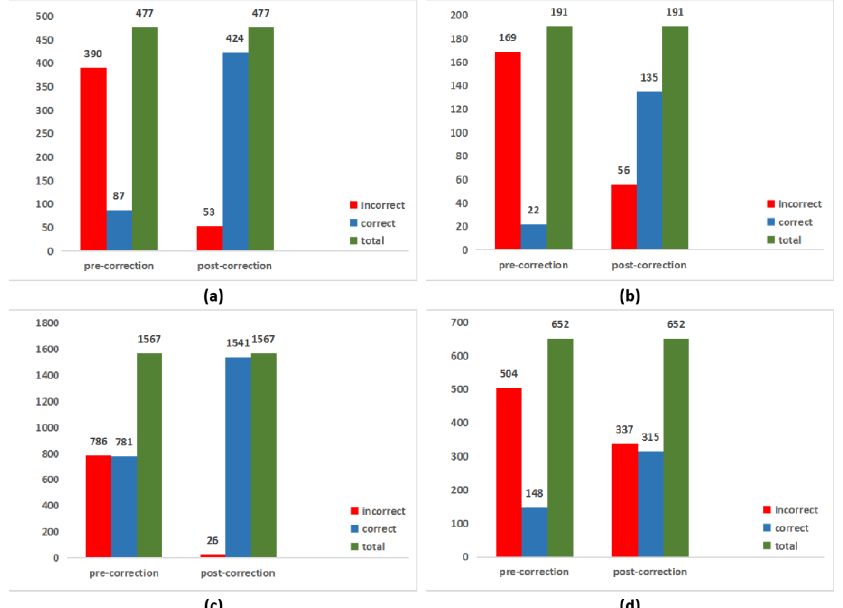
Figure 12. Correction e ff ect analysis. It shows the corrective e ff ect of Sample Set 1 and Sample Set 2. ( a , b ) are the sample-based overall correction e ff ect for Sample Set 1 and Sample Set 2, respectively; ( c , d ) are the noun-based overall correction e ff ect for Sample Set 1 and Sample Set 2, respectively. As shown in the figure, whether from the perspective of samples or nouns, the correction algorithm proposed in this paper achieved good results. The correction e ff ect of Sample Set 1 was better than that of Sample Set 2.